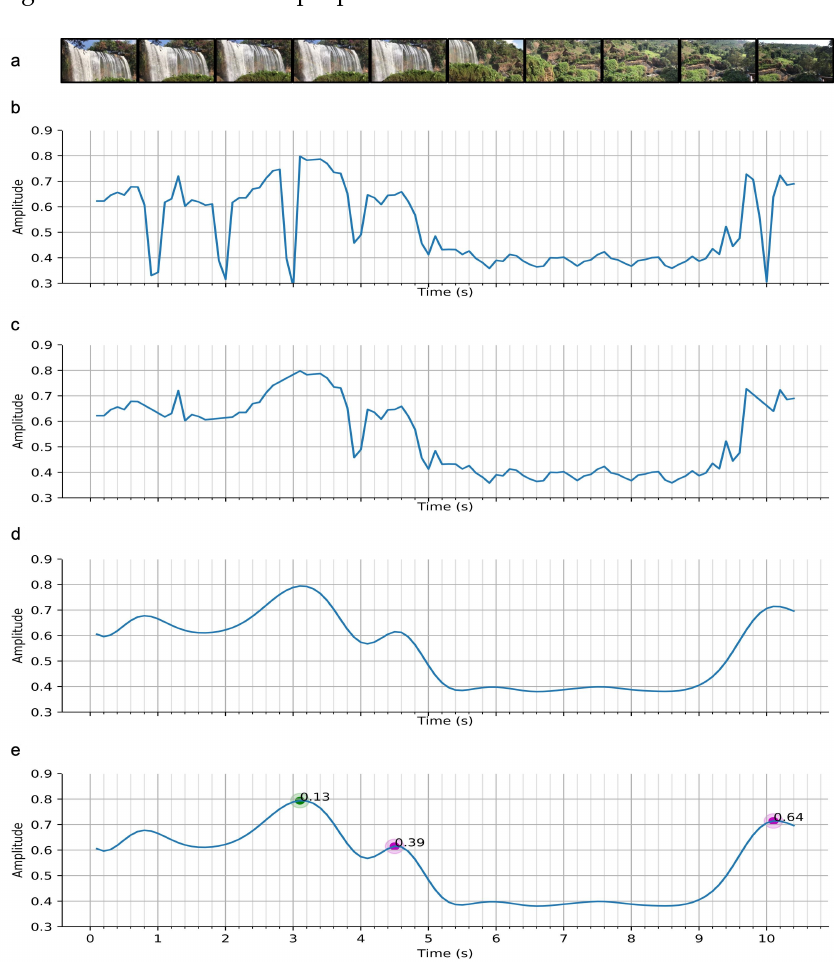
Figure 4. Raw signal to features pipeline: ( a ) Frames extracted from the scene video, ( b ) Frame similarity from Zhang et al. [54], ( c ) discontinuity removal, ( d ) 2.5Hz low-pass filter, ( e ) rule-based feature